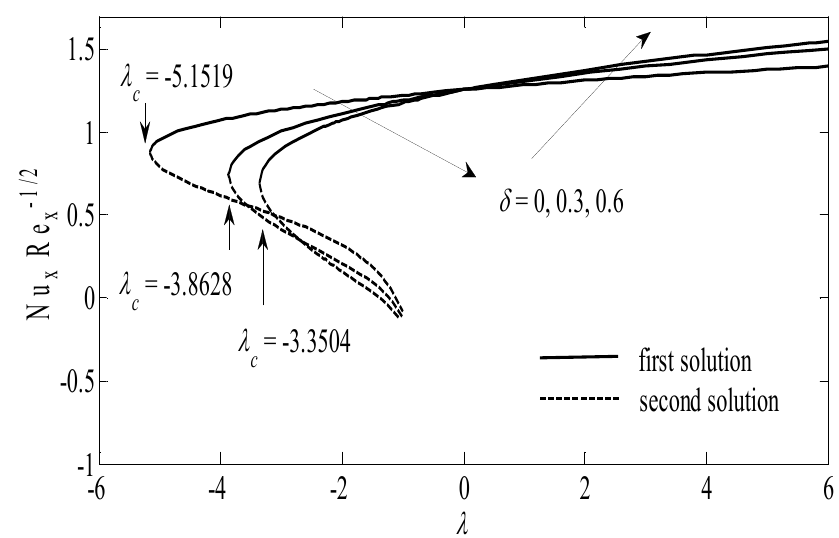
Figure 2. Variation of the Nusselt number with λ for different values of δ when ε = 1 and Pr = 1. Table 2. Values of critical values λ c for some values of δ when ε = 1 and Pr = 1. δ λ c